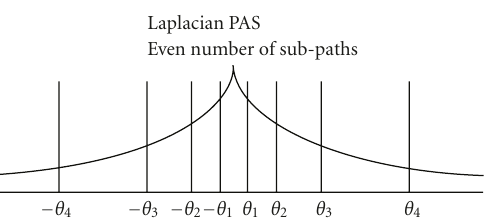
Figure 2: Subpaths distribution with equal power.